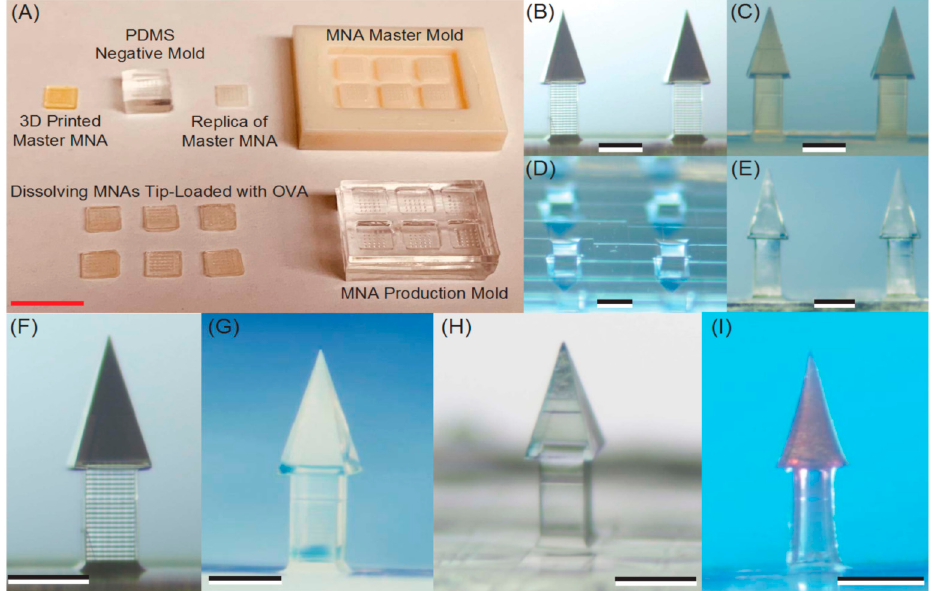
Figure 6. Fabrication of novel dissolving MNAs with undercut microneedles. ( A ) Finished items according to each stage of the production plan outlined. The scale bar measures 10 mm. ( B – I ) Optical stereomicroscopy was used to verify the geometric quality of the produced MNAs. The scale bars are 250 m in length. ( B ) Three-dimensional direct laser writing was used to generate the master MNA. ( C ) A two-stage micromolding approach was used to generate a replica of the master MNA (elastomer molding combined with UV-curable micromolding). ( D ) Wells formed like microneedles in an MNA manufacturing mold. ( E ) Dissolving CMC/trehalose MNA in the final stage, including a multicomponent vaccine (OVA + Poly(I:C)). ( F ) A closer look at a single undercut microneedle on the 3D-printed master MNA (as in B). ( G ) Magnification of an individual undercut microneedle on a master MNA replica at higher magnification (as in C ). ( H ) Dissolving PVP/PVA microneedle tip filled with Alexa680-labeled OVA at the end. ( I ) A final dissolving CMC/trehalose microneedle tip filled with doxorubicin, a red-colored, chemotherapeutic, small-molecule medication, is shown. (Taken from